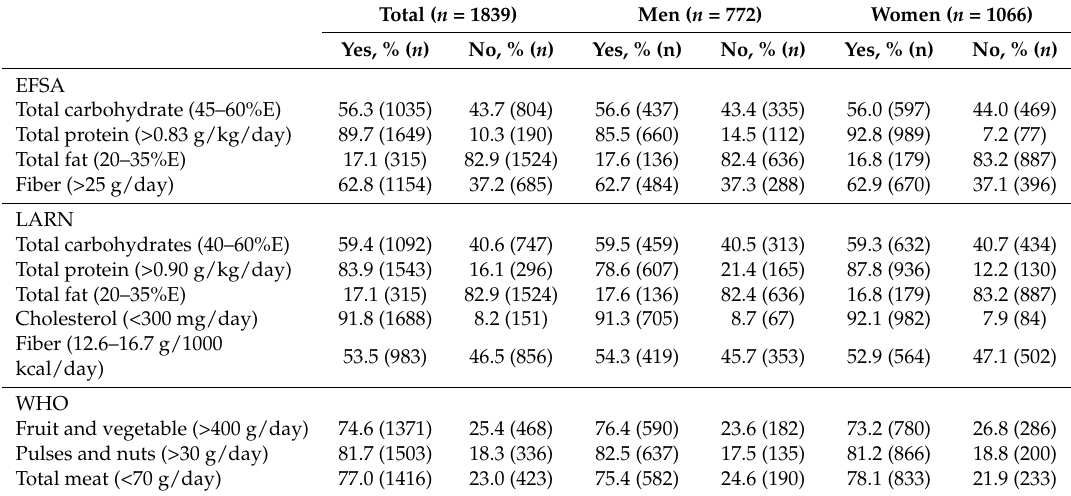
Table 5. Percentage of study population meeting various recommendations for macronutrients (EFSA, LARN) and selected food groups (WHO).